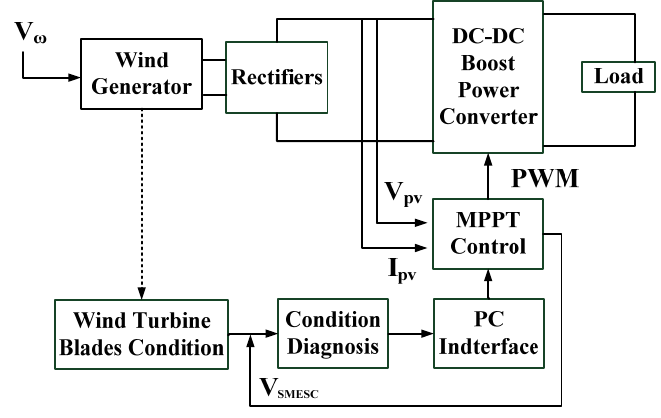
Figure 2. The wind power generation system schematic.